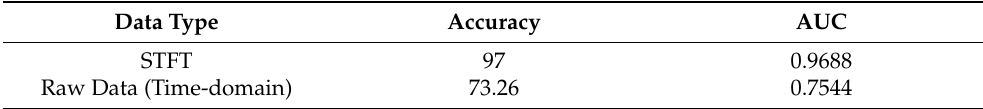
Table 7. Comparison of deep learning results of STFT and raw